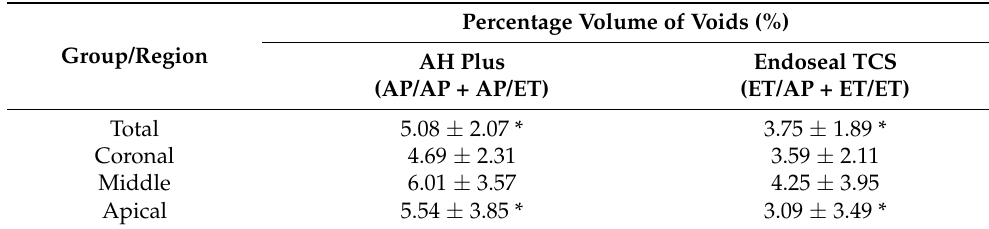
Table 1. Percentage volumes of voids (mean ± standard deviation) after first obturation using AH plus and Endoseal TCS in the whole canal and in each third.